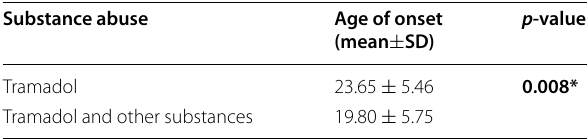
Table 5 Age of onset substance abuse among the studied